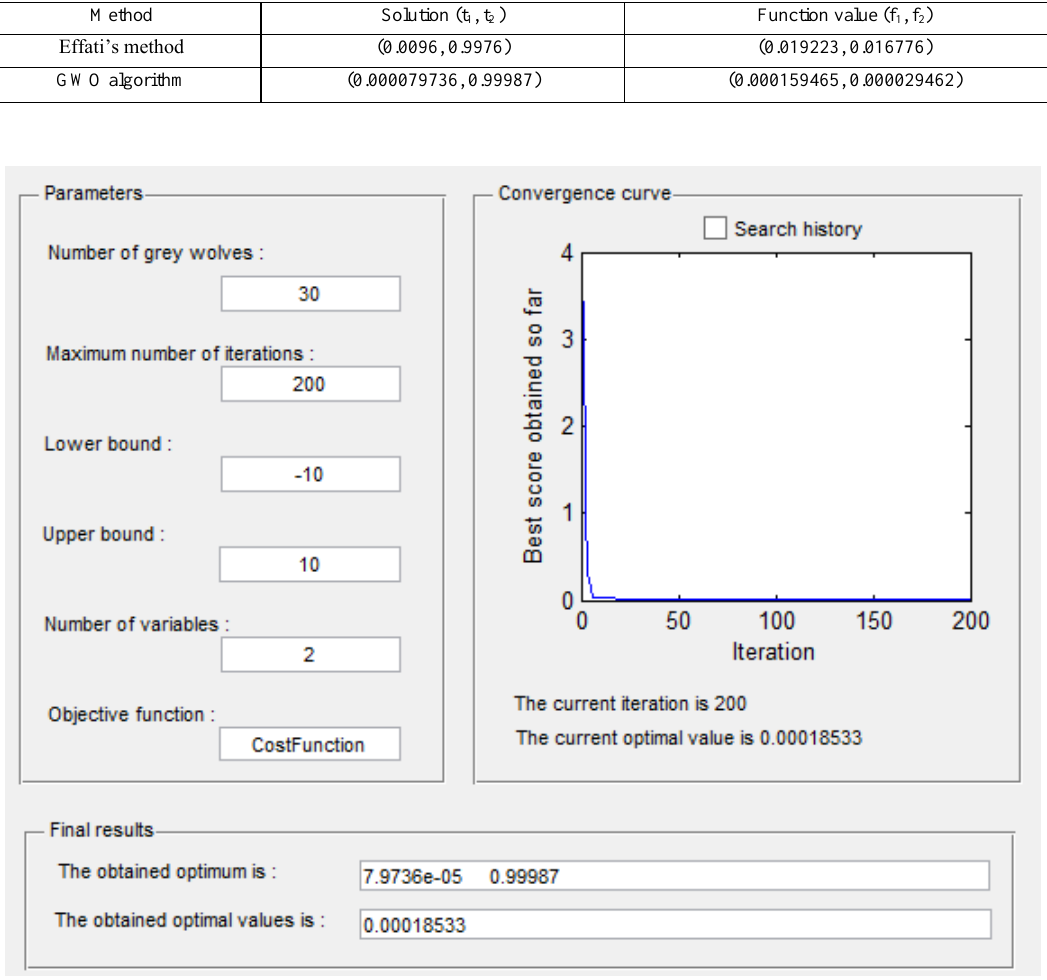
Figure 4. GWO search history for Problem